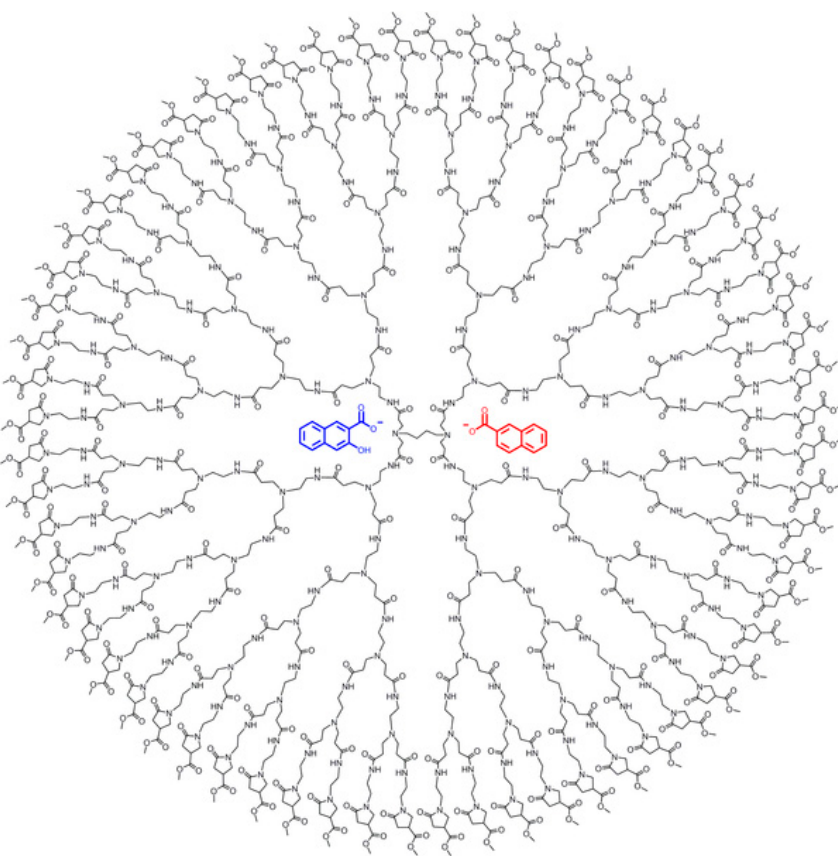
Figure 48. Two anionic naphthanoate guest molecules used as non-steroidal inti-inflammatory models shown to be unimolecularly encapsulated in a 4-(carbomethoxy)-pyrrolidone) functionalized (G4) PAMAM dendrimer host. Reprinted from [193].